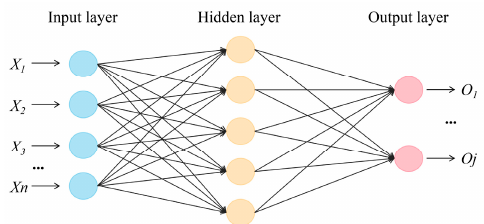
Figure 2. The structure of the BP neural network.